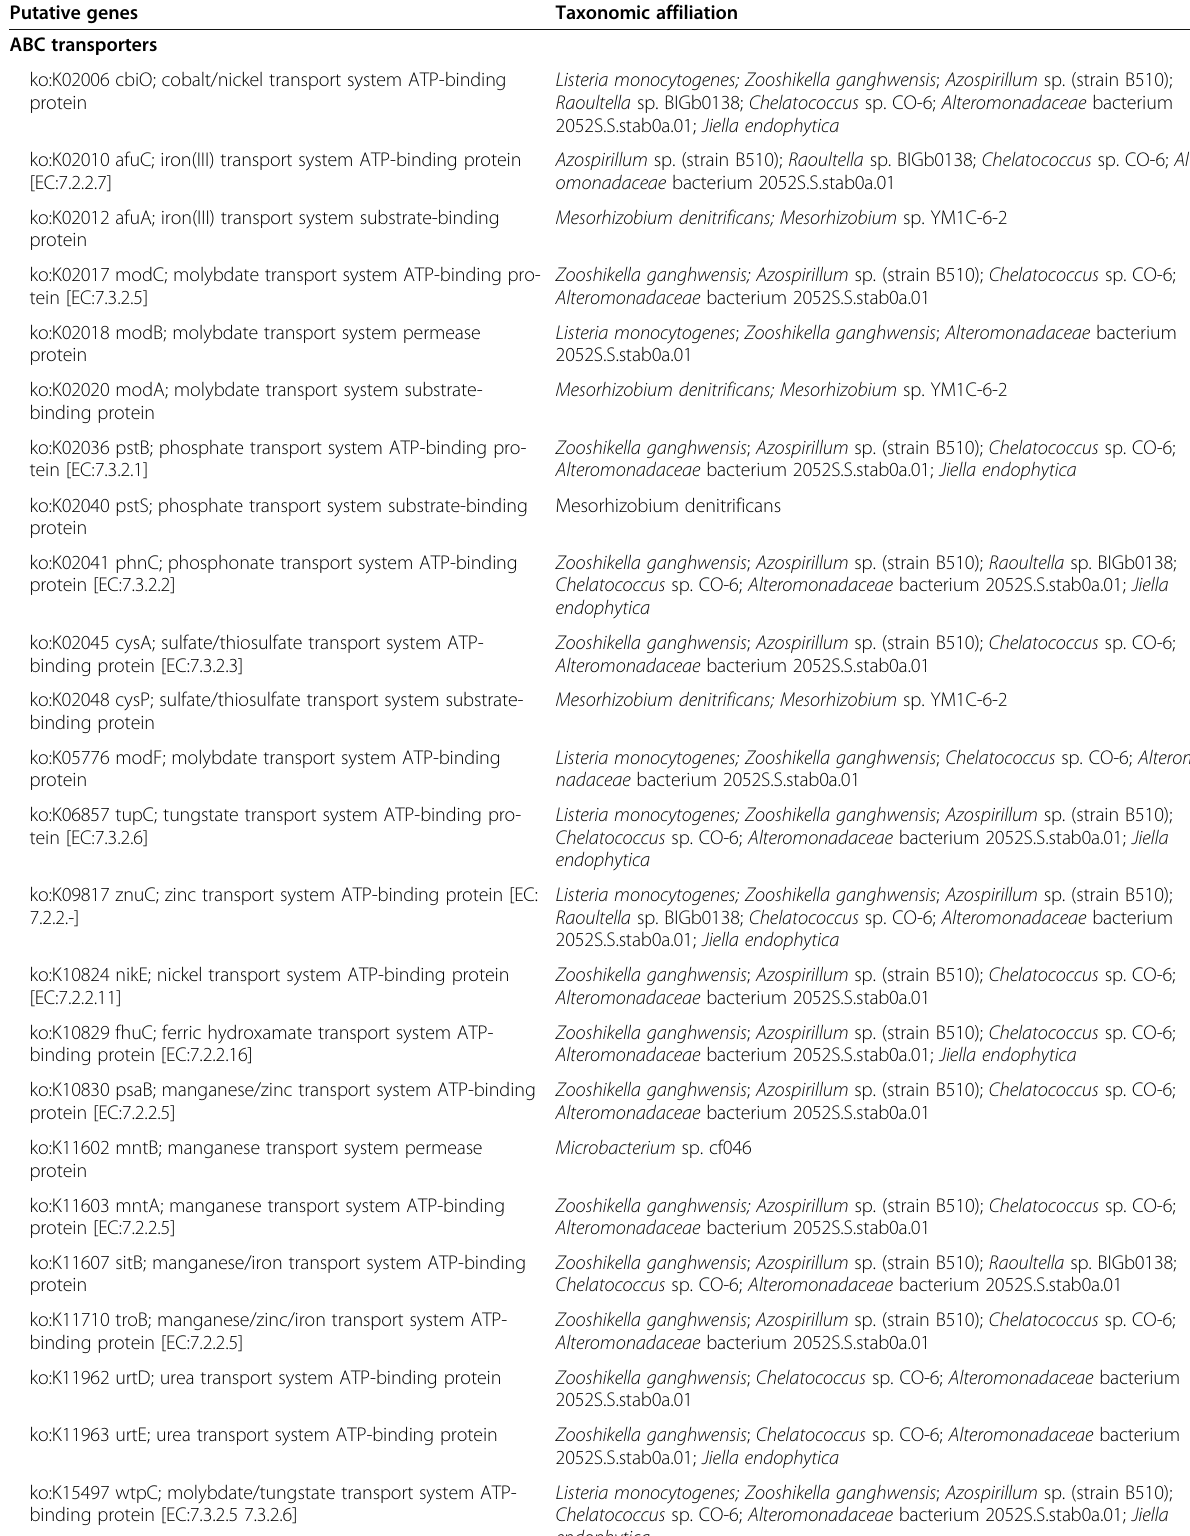
Table 3 Putative genes for ABC transporters and their two-component systems detected in the FN1 metagenome and